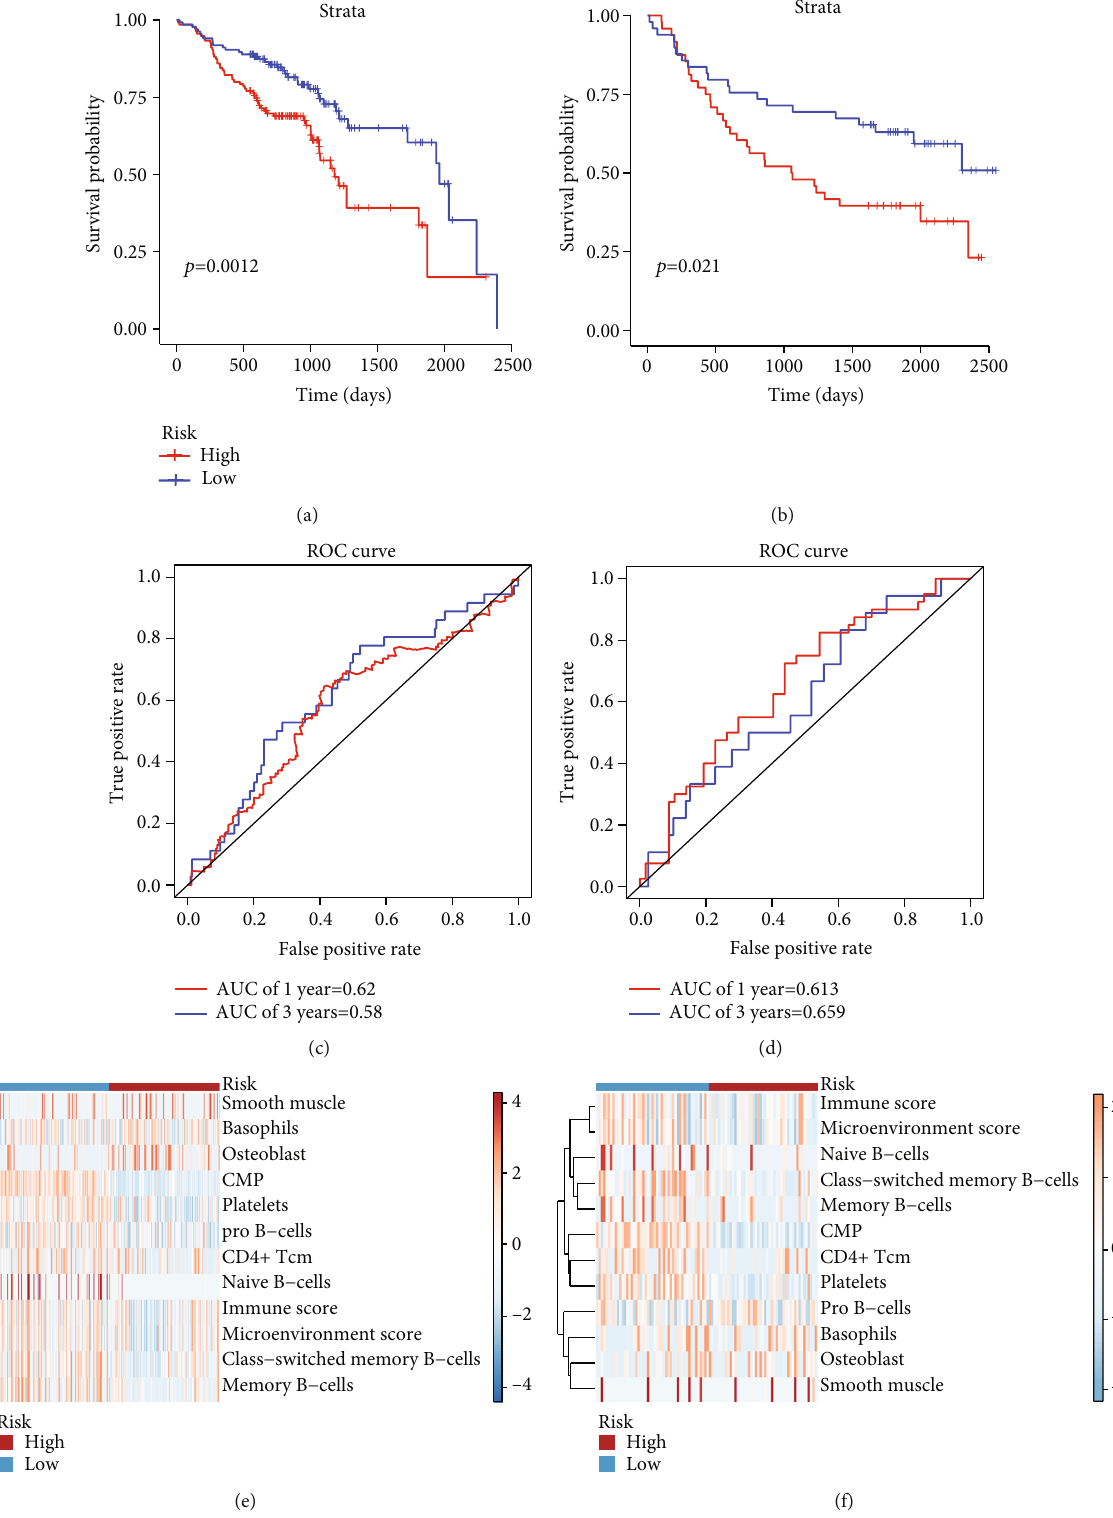
Figure 3: Validation of the established prognostic risk model. (a, b) Kaplan – Meier plots of prognostic model performance in GSE65858 and GSE41613, with red line representing the high-risk group and blue line representing the low-risk group. (c, d) Receiver operating characteristic (ROC) curves for the low- and high-risk groups in GSE65858 and GSE41613, with area under the curve (AUC) scores. (e, f) Heatmap showing di ff erential expression of 12 elements in the prognostic model between the low- and high-risk groups in GSE65858 and